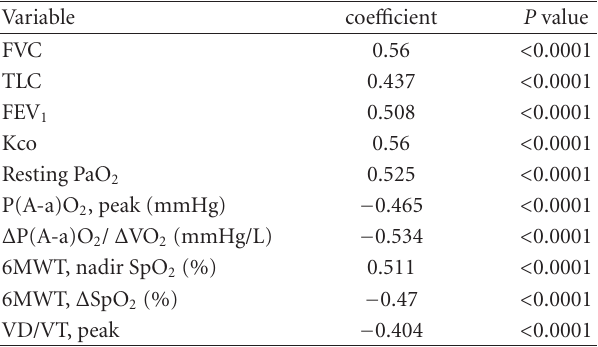
Table 3: Correlation between percent-predicted DLco and other